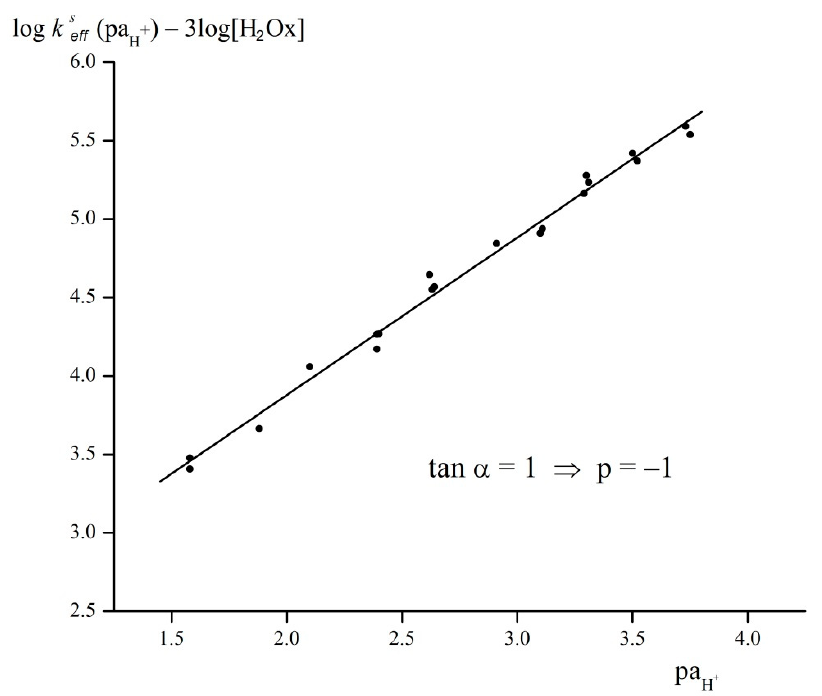
pa for the complex FeOx 3 (BCH 3 ) 2 ( 5 ) at + H